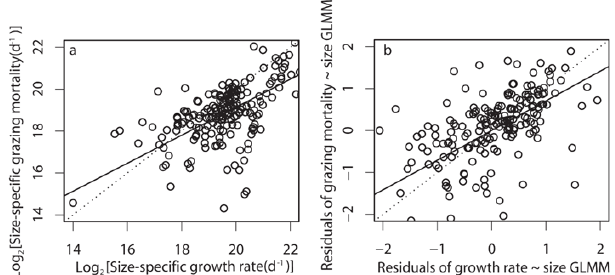
Fig. 4. Scatter plot of log 2 transformed size-specific grazing mor- tality ( m ) versus growth rate ( µ 0 ). Panel a shows the regression be- tween size-specific grazing mortality and size-specific growth rate using GLMM, with stations as the random effect (slope = 0.668, p < 0 . 001). Panel b shows the regression between the residuals from the size-specific grazing mortality GLMM against the resid- uals from the size-specific growth rate GLMM (slope = 0.708, p < 0 . 001). The solid line indicates the significant regression line, and the dashed line indicates the diagonal